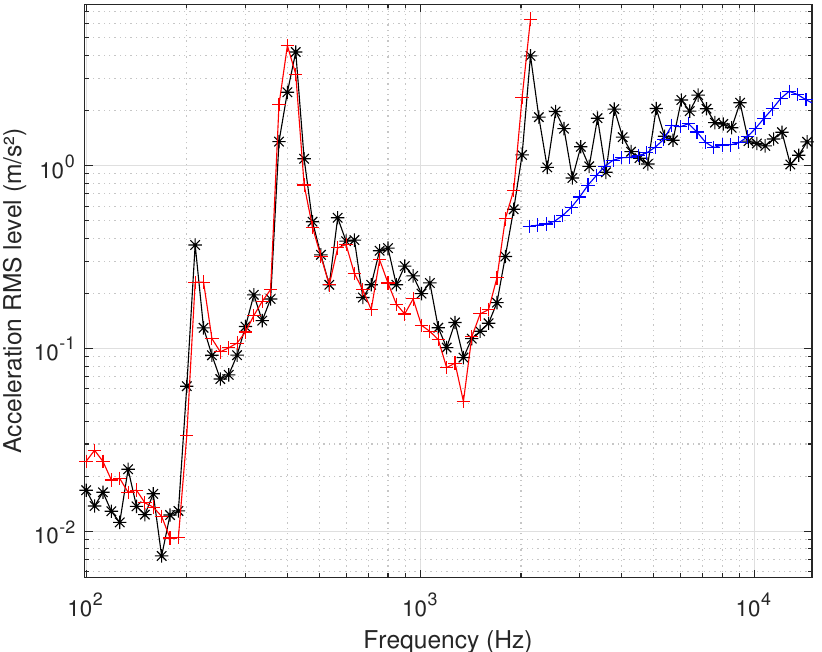
Figure 22. Full-frequency test–simulation comparison at point (c) on the bottom, one-twelfth-octave frequency band representation. The experimental response (black curve with stars) is compared with the combination of the FE-BEM results (red curve with +) and SEA results (blue curve with